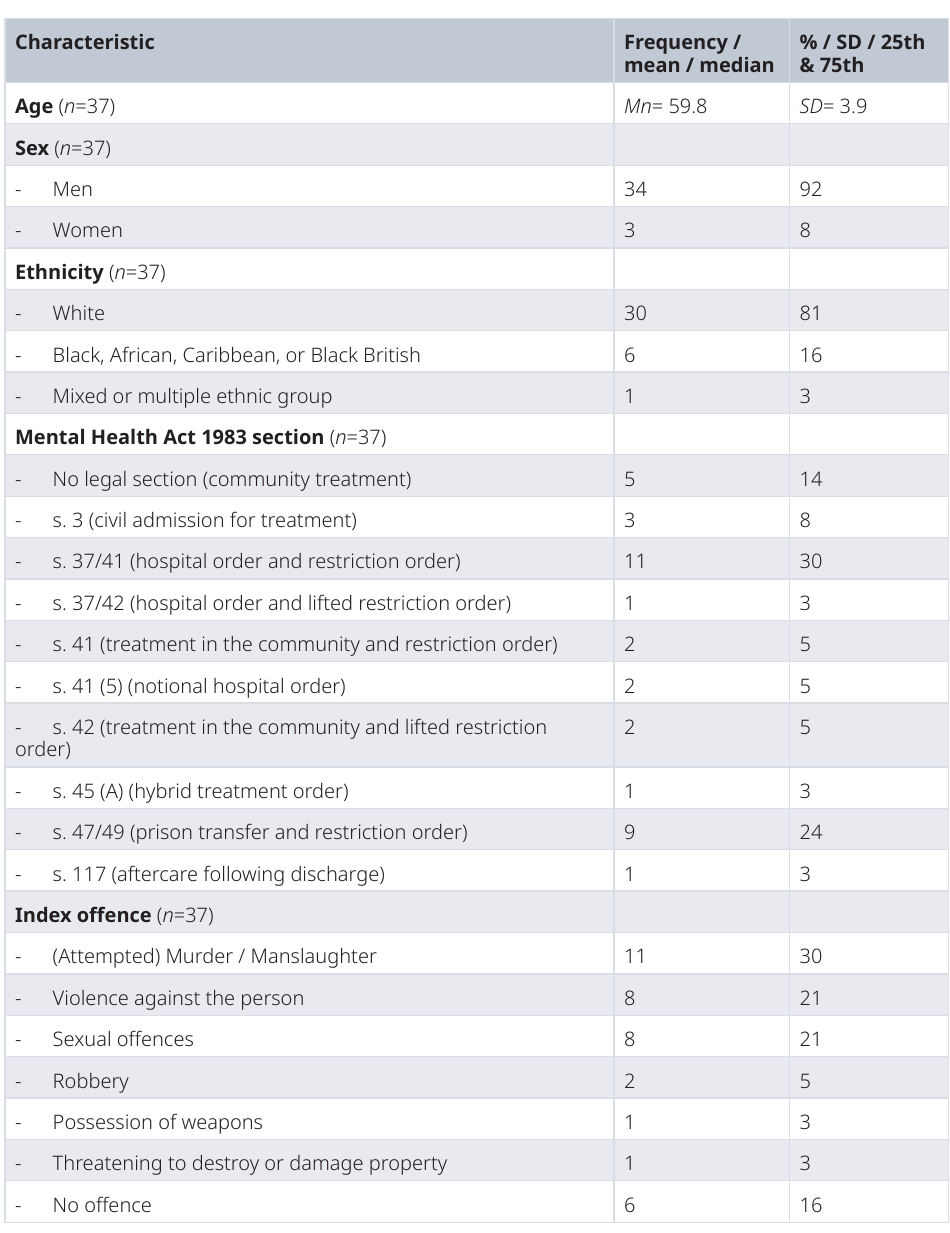
Table 2. Demographic, clinical and legal characteristics of the